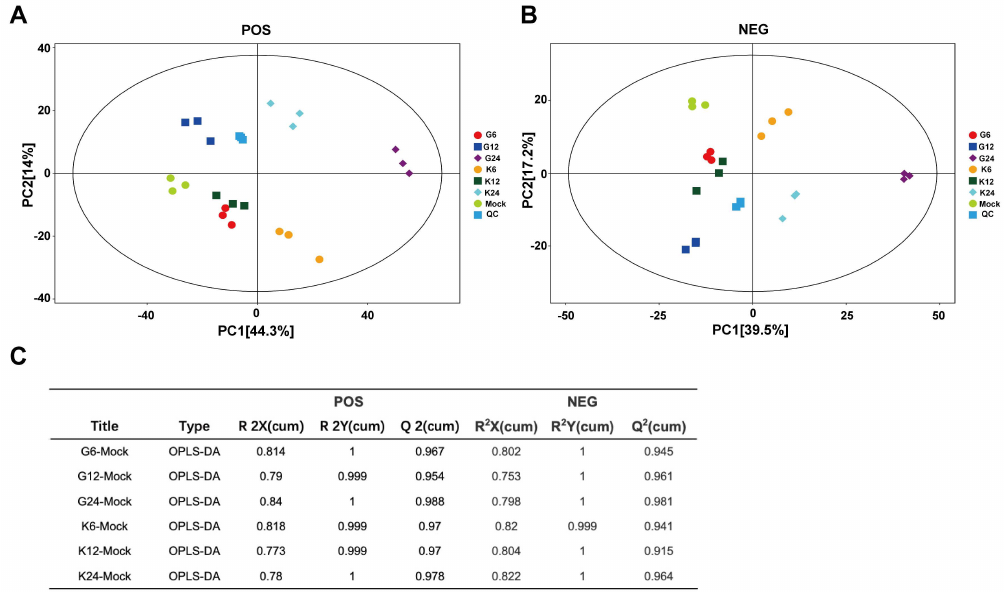
Figure 2. Score scatter plots of PCA and OPLS-DA of PRV-infected and uninfected cells. ( A , B ) Score scatter plot of the PCA model for the different infection groups versus mock group. Electrospray ionization served as the source of UHPLC-QE-MS, including positive and negative ion modes (POS and NEG). ( A ) was derived from POS and ( B ) from NEG. The lines denote 95% confidence interval Hotelling’s ellipses. ( C ) OPLS-DA model for the different PRV-strain infection group versus mock